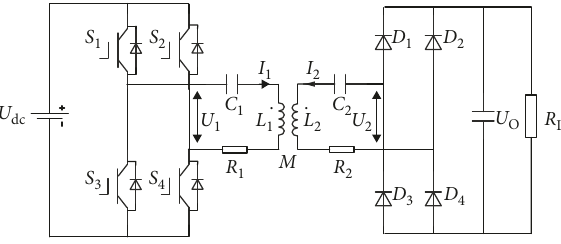
Figure 4: Circuit topology of wireless power transmission